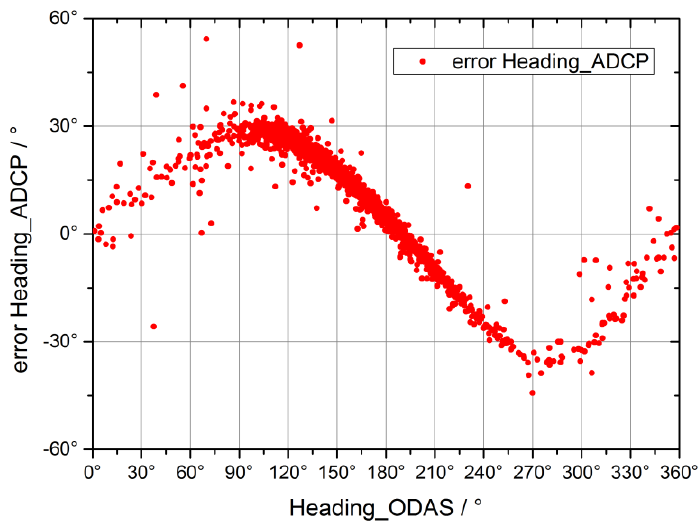
Figure 10. Trend of the error committed by the ADCP compass as a function of the rotation of the buoy (measured by the ODAS compass), computed for each individual profile acquired.